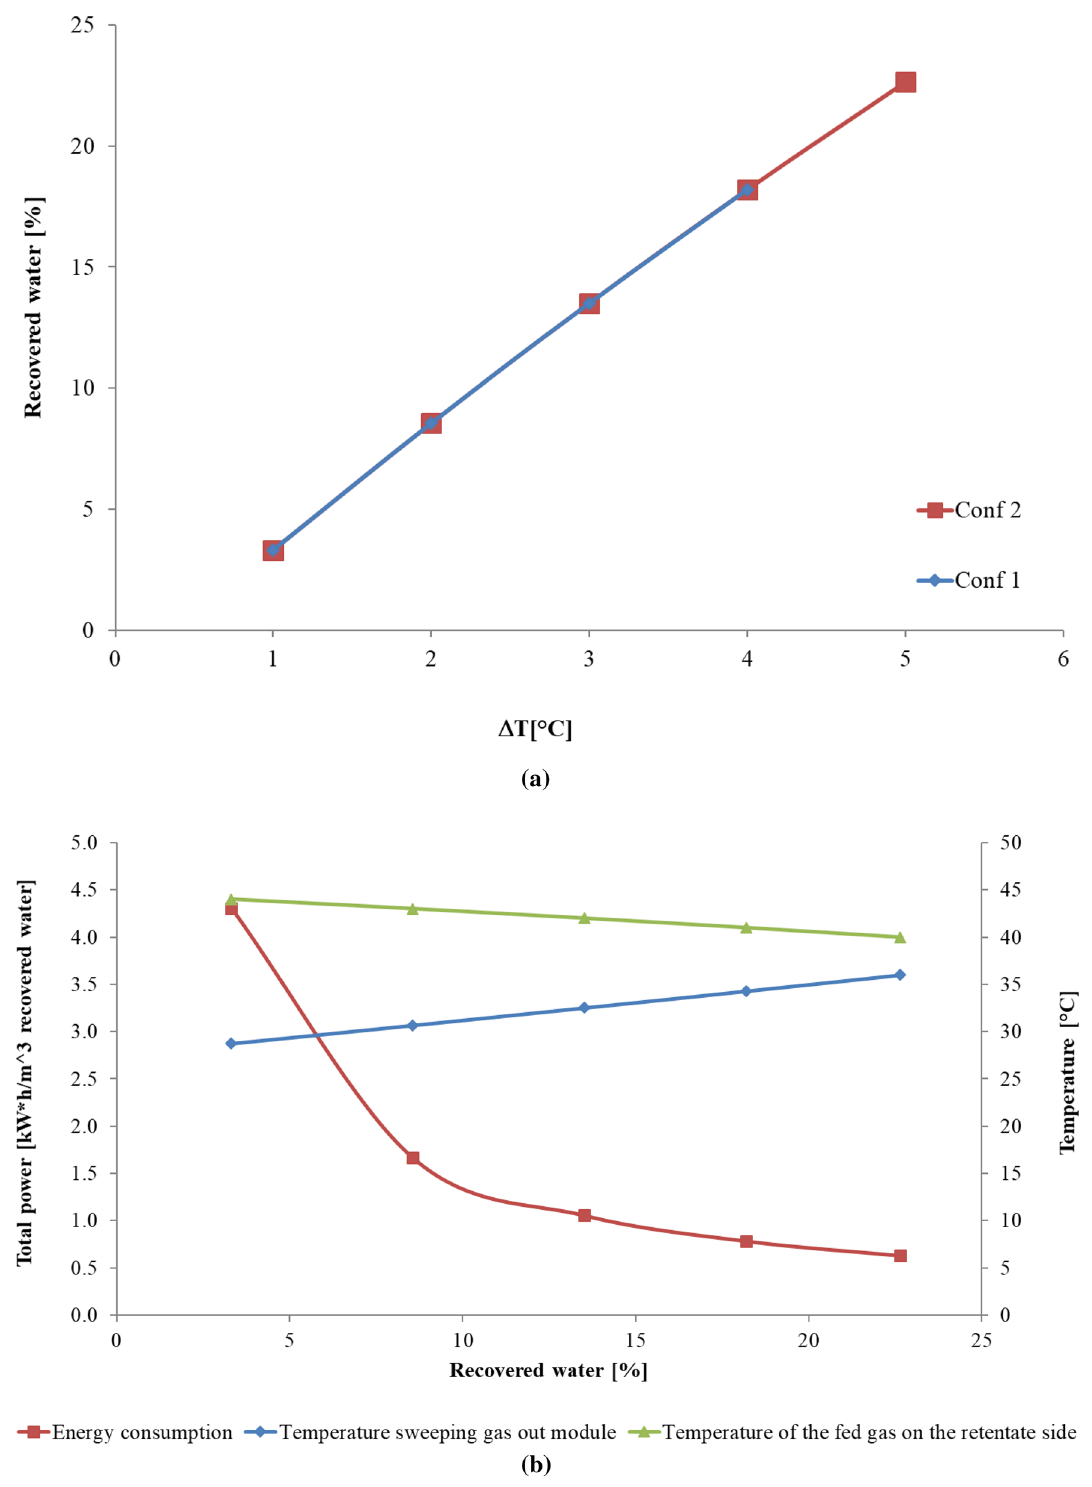
Fig. 6 a Recovered water versus feed cooling gradient (ΔT) for configuration 1 and configuration 2 ( I = 3) and b energy consumption for con- figuration 2 ( I = 3). (Feed temperature = 45 °C; RH feed =